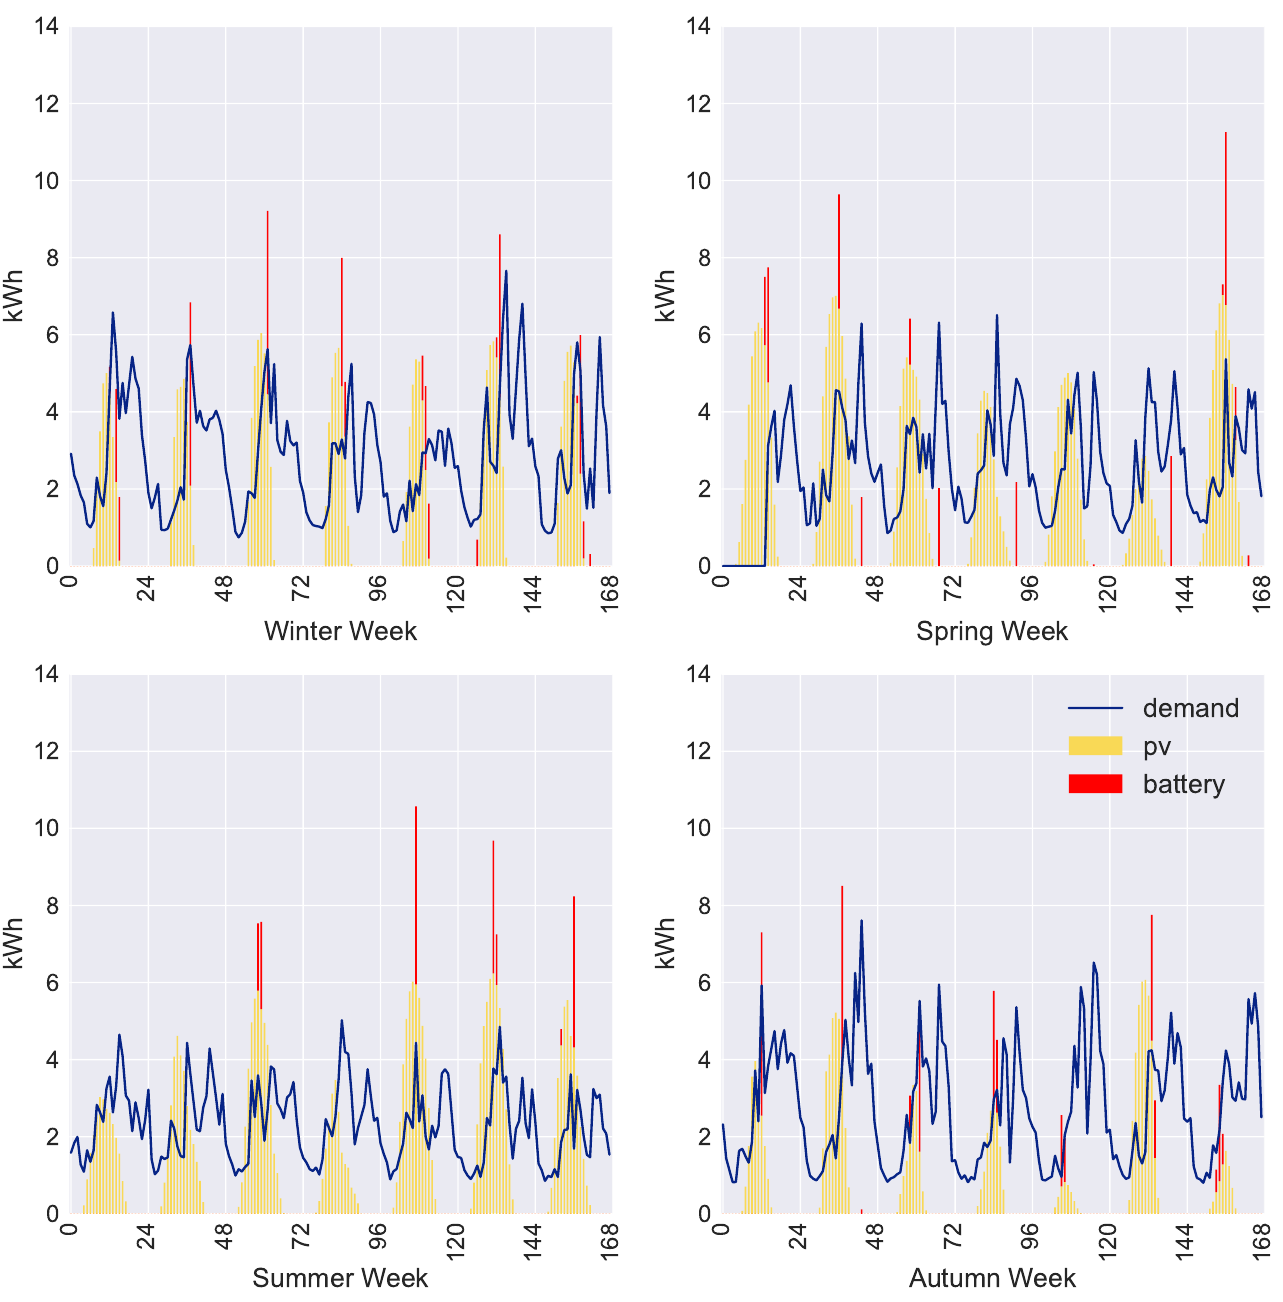
Figure A5. Weekly electricity production per technology source: Location